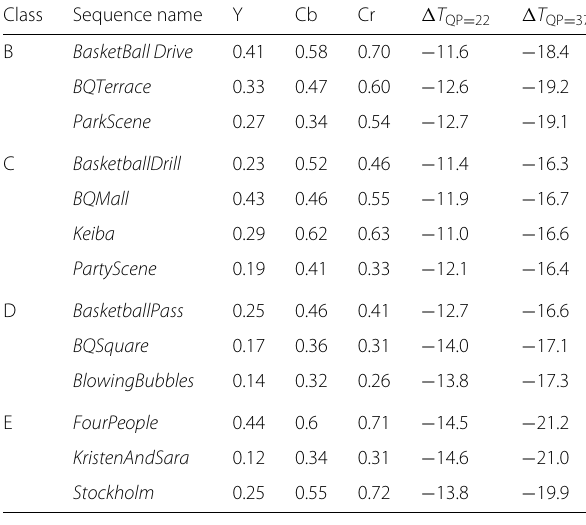
Table 4 BD-Rate increase of the proposed two-step method for a subset of test image sequences, β =